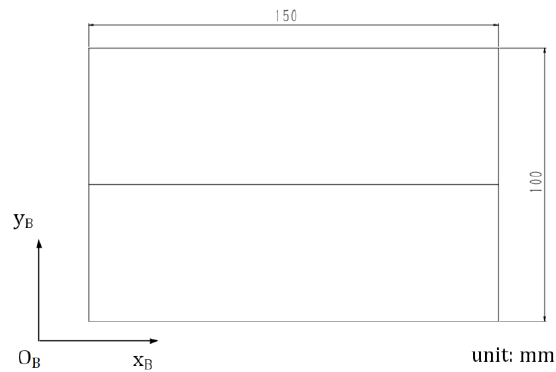
Figure 15. Dimension and orientation of the plane workpieces.